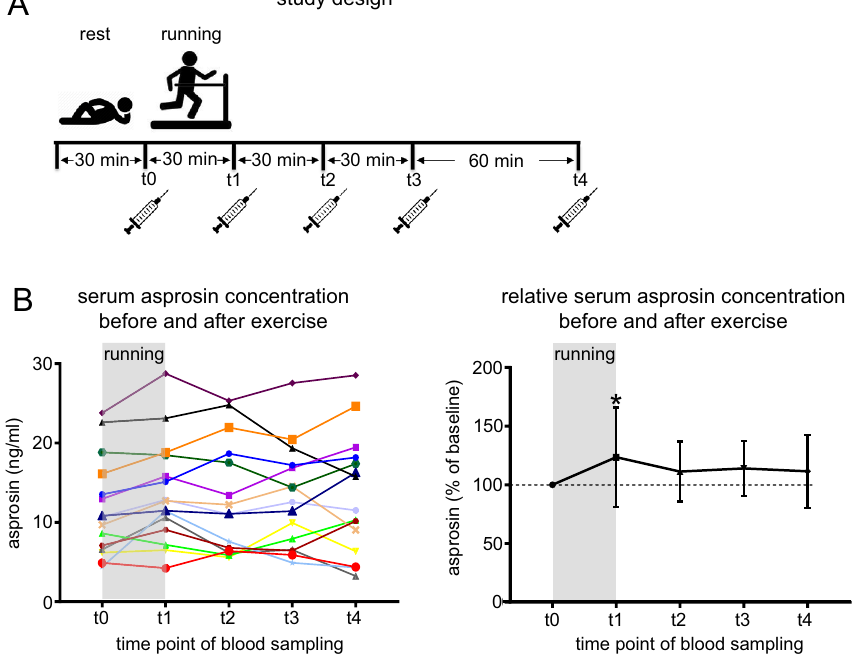
Figure 5. Asprosin serum levels increase after 30 min of running exercise. ( A ) Schematic diagram representing the overall study design showing exercise and rest regimens and blood sampling time points. ( B ) (Left) Absolute serum asprosin concentration (ng/ml) for each subject before and after running exercise (n = 15 subjects); t0: immediately before running exercise (after 30 min rest in sitting position); t1: immediately after exercise; t2, t3, and t4 represent 30 min, 60 min, and 120 min after exercise, respectively. (right) Relative serum asprosin concentration after running exercise (t1, t2, t3, and t4) normalized to its baseline concentration before exercise (t0) and represented as percentage. A significant increase of asprosin concentration was observed immediately after running exercise; asprosin concentration (c) at t0 = 100%; c(asprosin) t1/c(asprosin) t0 = 123.7 ± 42.3%; c(asprosin) t2/c(asprosin) t0 = 111.3 ± 25.5%; c(asprosin) t3/c(asprosin) t0 = 114 ± 23.40%; c(asprosin) t4/c(asprosin) t0 = 111.5 ± 31.06%; * P = 0.0385. Serum (25 µl) fourfold diluted in PBS (75 µl) for asprosin concentration analysis. Data were analyzed using Graphpad Prism version